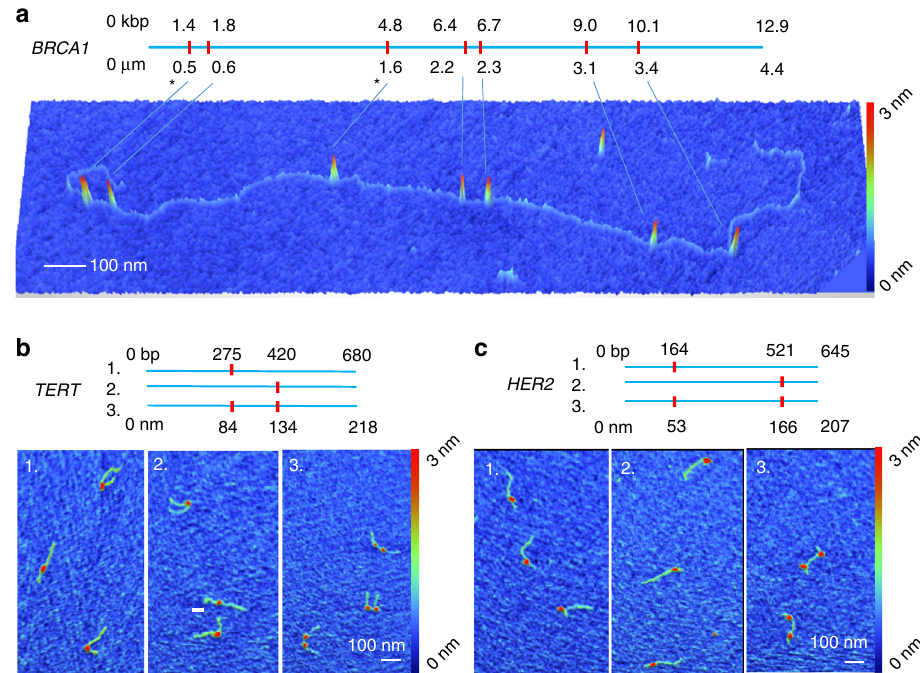
Fig. 2 sgRNA – Cas9 complexes on DNA. a Map and the corresponding HS-AFM image of Cas9-labeled BRCA1 amplicon. Red tick marks on the map indicate locations of the Alu repeat-targeted sgRNA-binding sites. In the image, sgRNA – Cas9 protein complexes appear as 3-nm-tall bumps on the DNA backbone. The amplicon sequence includes fi ve perfect matches to the 20-bp sgRNA sequence and fi ve single base-pair mismatches. Single base-pair mismatches label at roughly one-half the frequency of perfect matches. The star (*) indicates Cas9 bound at locations with a single mismatch, while all other locations are perfect matches. b , c Cas-9-labeled TERT and HER2 amplicons. The sharp bend induced in the DNA backbone by the sgRNA – Cas9 complex is evident